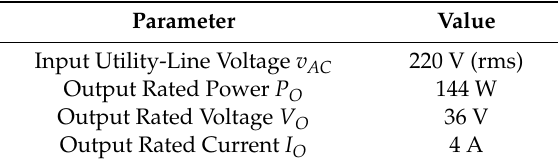
Table 1. Specifications of the presented singles-stage LED streetlight driver.